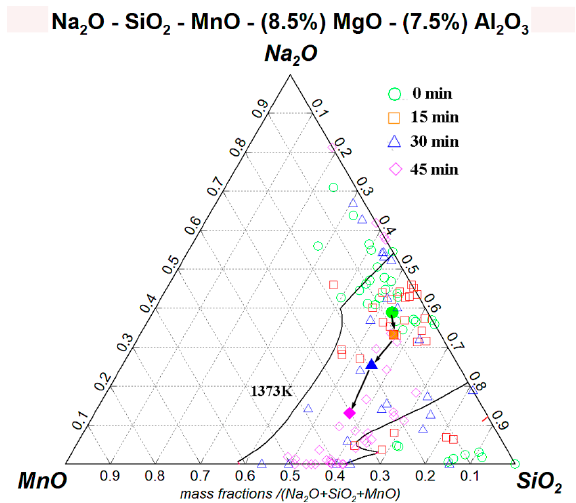
Figure 14. Distribution of inclusions at di ff erent times after NaF addition in Heat D (the solid symbols represent the average composition at di ff erent times).